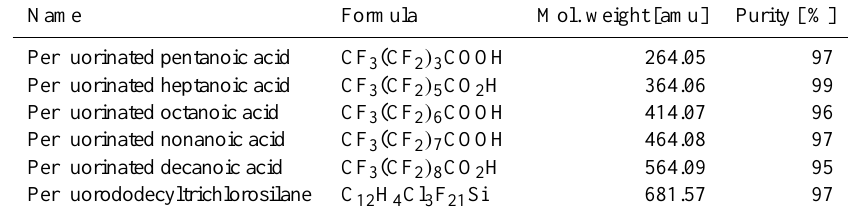
Table 2. Compounds used for depletion method. The perfluorinated acids only differ in the number of CF 2 building blocks. Name